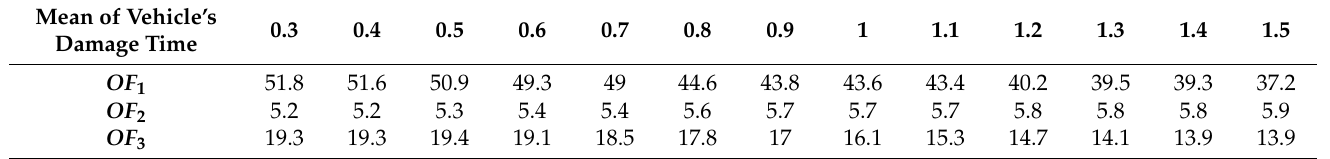
Table 9. Sensitivity analysis of the changes mean of vehicle damage